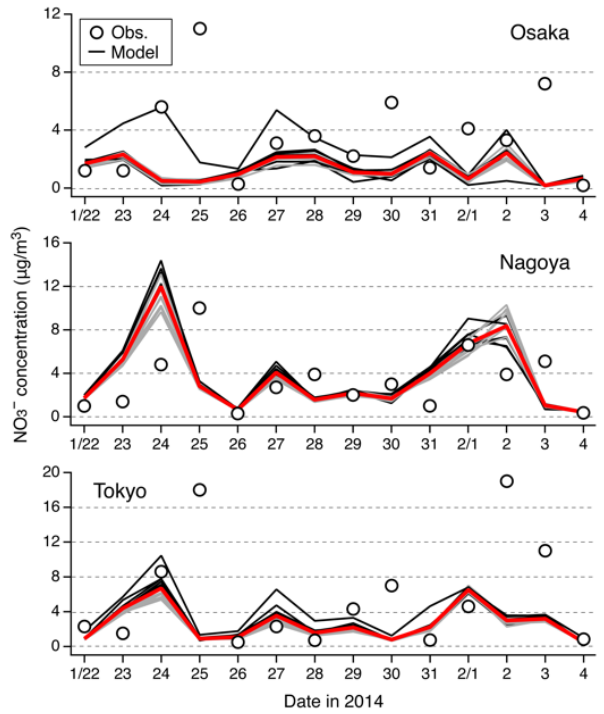
Figure 5. Temporal variation of the observed (circles) and modelled (lines) NO 3 − concentration at specific sites in (top) Osaka, (center) Nagoya, and (bottom) Tokyo (see Figures 2 and 4 for the location of these sites). Black lines represent models using different external datasets, grey lines represent models using the common dataset (see also Table 1), and red lines represent the ensemble mean.